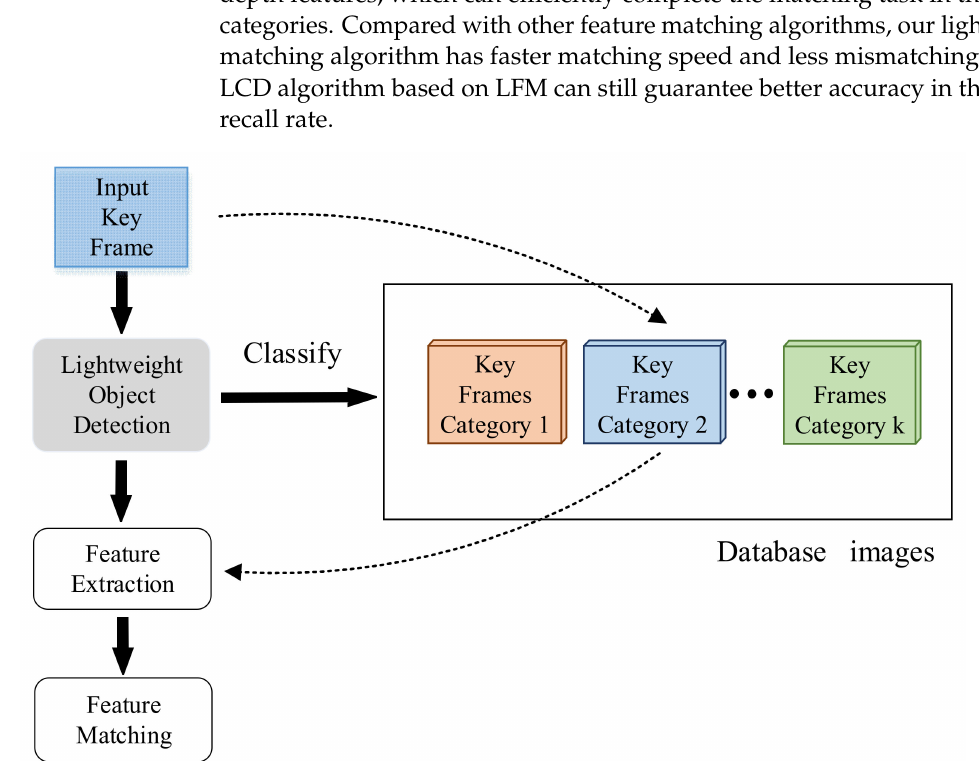
Figure 1. This is an overview of the proposed LFM framework; dashed lines indicate the category of the input key frame image. The database image consists of the key frames image entered